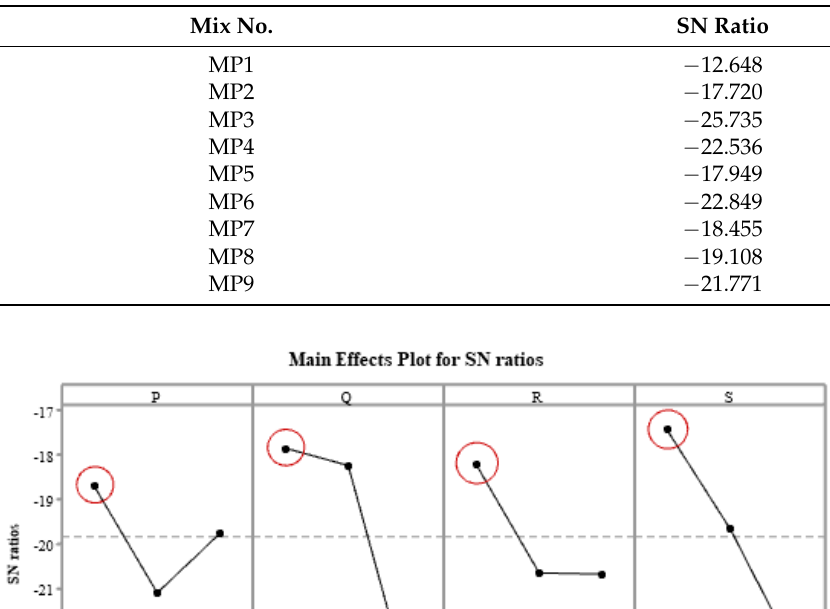
Table 11. SN ratio of total weight.